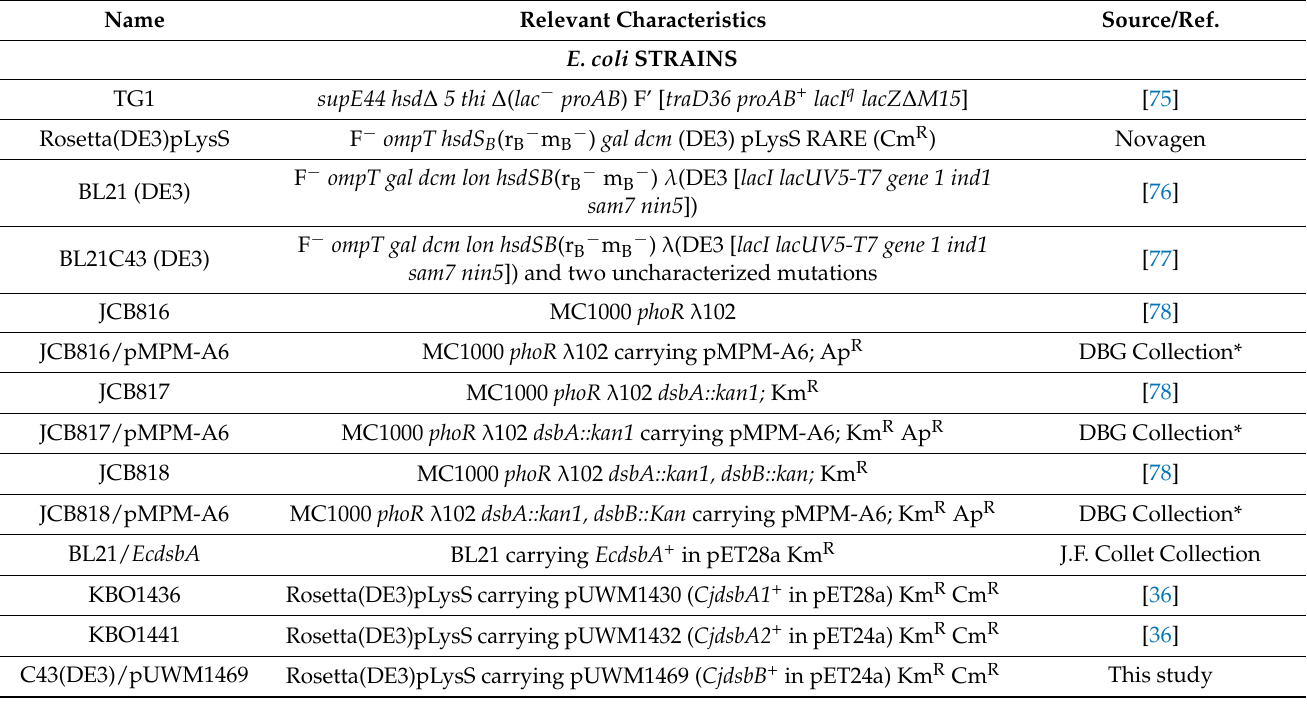
Table 5. Bacterial strains, plasmids and primers used in presented study (DBG Collection*—Department of Bacterial Genetics University of Warsaw